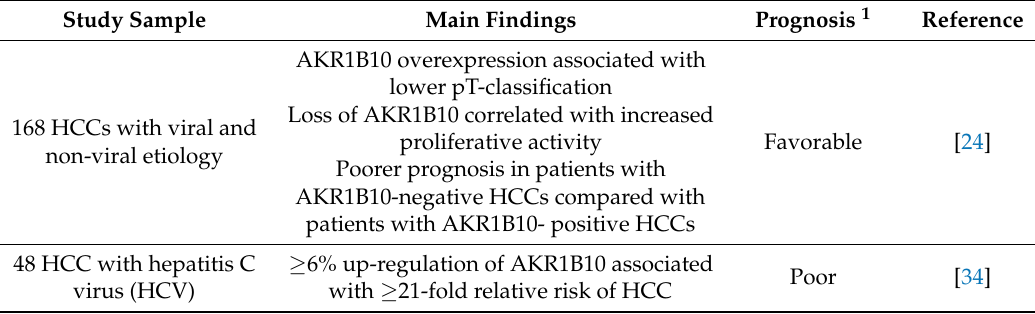
Table 2. Diagnostic and prognostic impact of AKR1B10 levels in